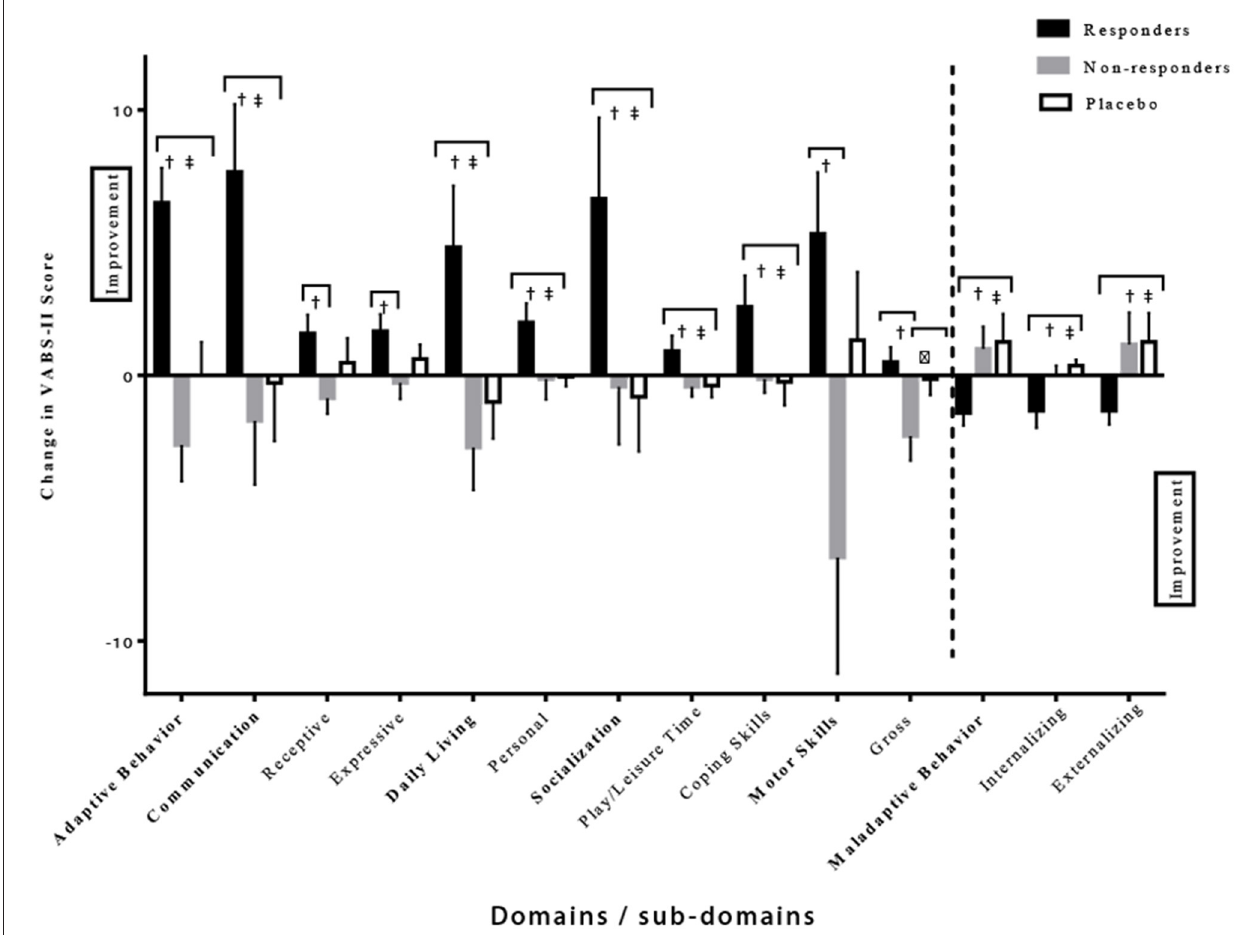
FIGURE 5 | Significant differences in various domains/sub-domains of VABS-II in the responder, non-responder and placebo groups. † Significant difference between responder and non-responder groups. ‡ Significant difference between responder and placebo groups. δ Significant difference between non-responder and placebo groups. One-tail t -tests were utilized with significance reached at p < 0.05. VABS-II, Vineland Adaptive Behavior Scale, 2nd